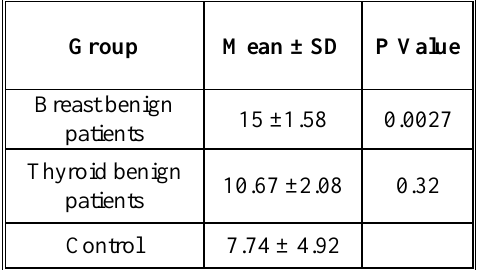
Table 1: CA19-9 values in sera of patients